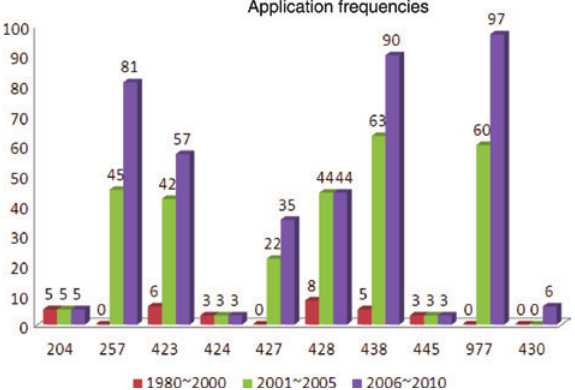
Figure 5: The application frequencies of ten technical classifications in three